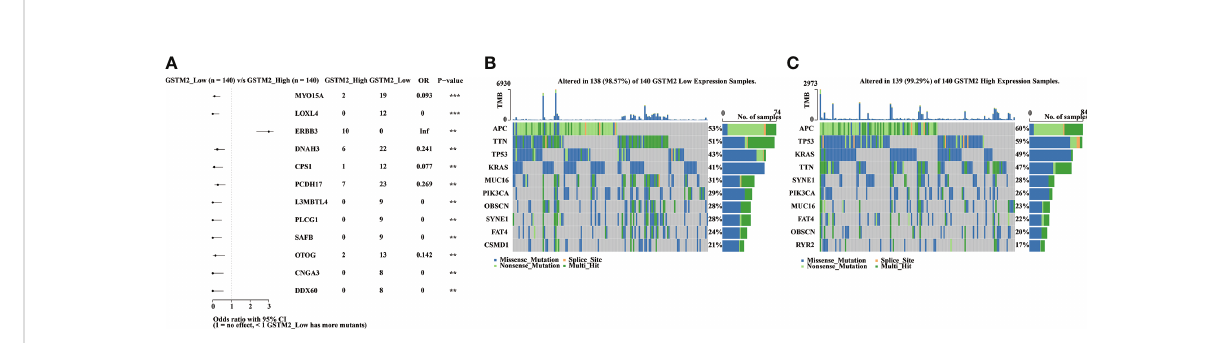
FIGURE 8 The Mechanism Underlying GSTM2 in Colon Cancer might be Associated with the Functions of PCDH17 mutations. (A) The forest map showing differential mutant genes between GSTM2 high and low expression groups. (B, C) The waterfall maps showing genes ’ mutation frequencies in each group. **p < 0.01 and ***p <